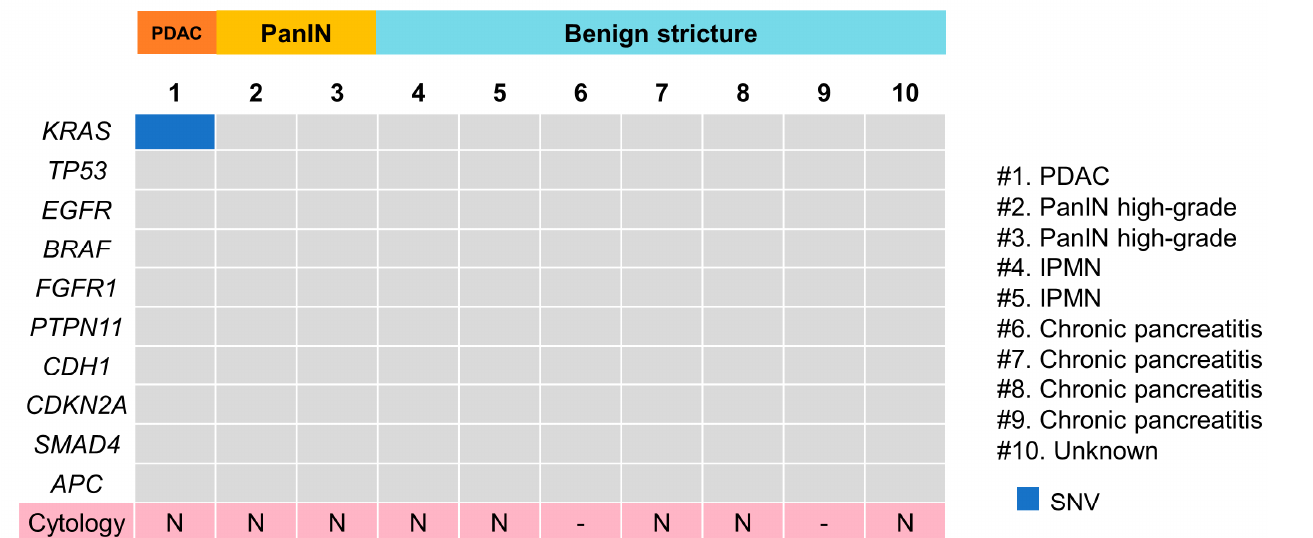
Figure 3. Pathogenic gene alteration profile in pancreatic juice cfDNA. PDAC, pancreatic ductal adenocarcinoma; PanIN, pancreatic intraepithelial lesion; IPMN, intraductal papillary mucinous neoplasm. KRAS mutation alone was detected in one PDAC case. (#) means case number.